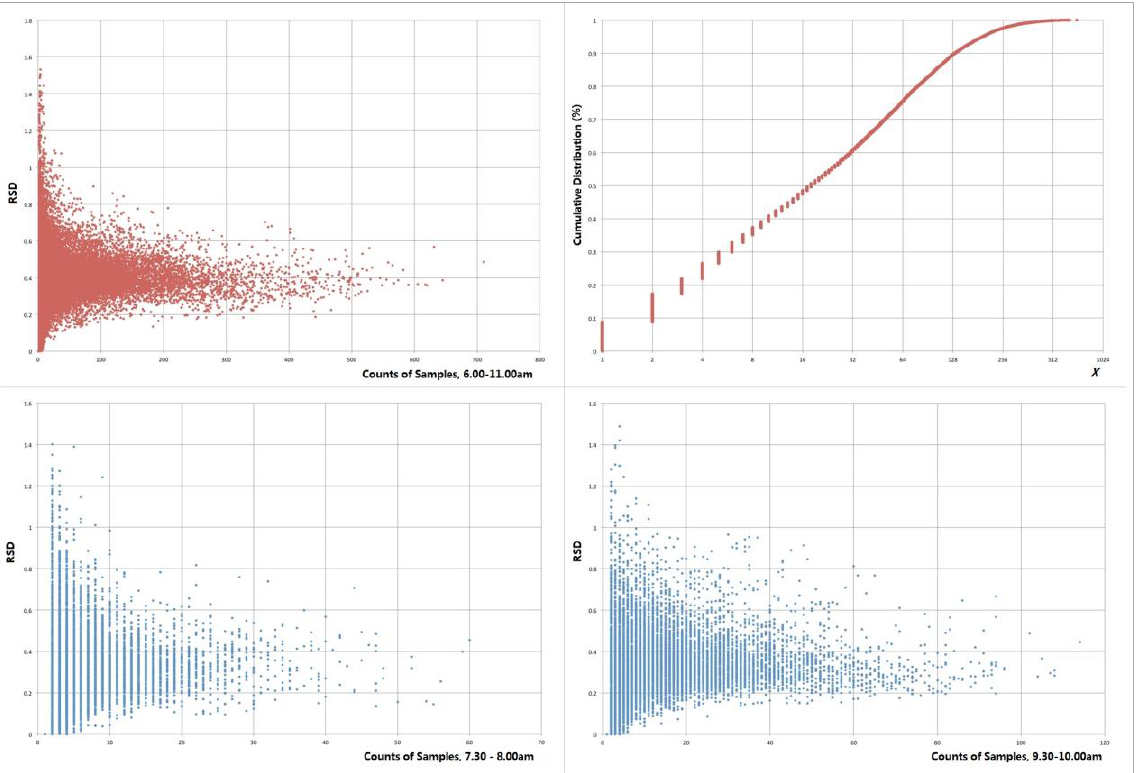
Figure 3. Relative Standard Deviation. Top-left plot shows RSD as a function of sample size for the full length of the morning peak period (6.00 – 11.00am). Top-right plot shows the cumulative distribution of links with sample size less than x. Bottom plots show RSD as a function of sample size for the 7.30-8.00am and the 9.30-10.00am time slots. As expected, as the sample size increases) the relative deviation for the shorter time periods tends to lowers values. Average RSD for all links is 0.39 for the 6.00-11.00am period, and 0.32 and 0.33 respectively for the 7.30-8.00am and 9.30-10.00am periods.